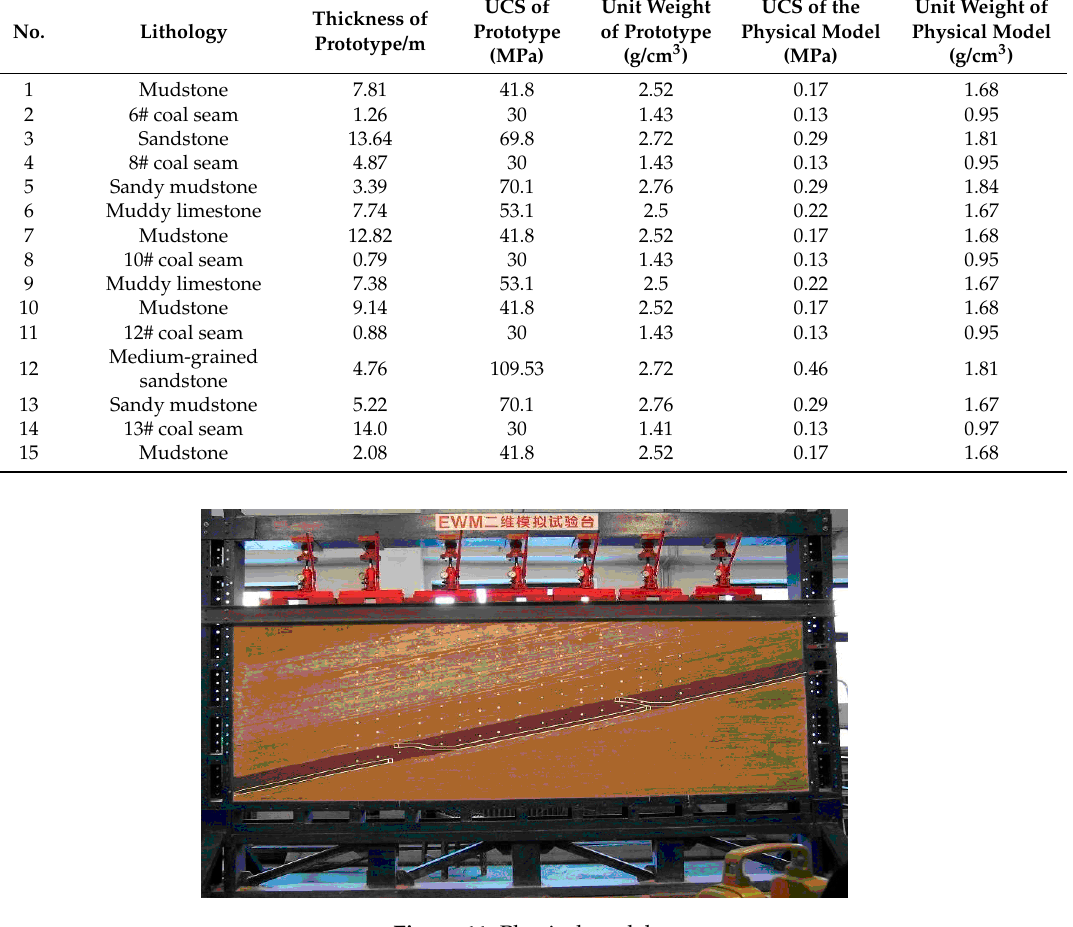
Table 4. Parameters of materials for physical modeling.